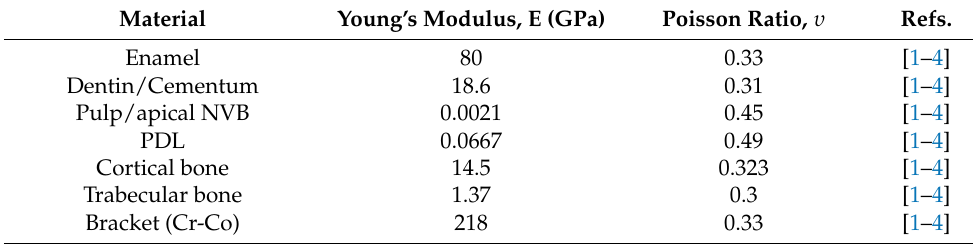
Table 1. Elastic properties of materials.